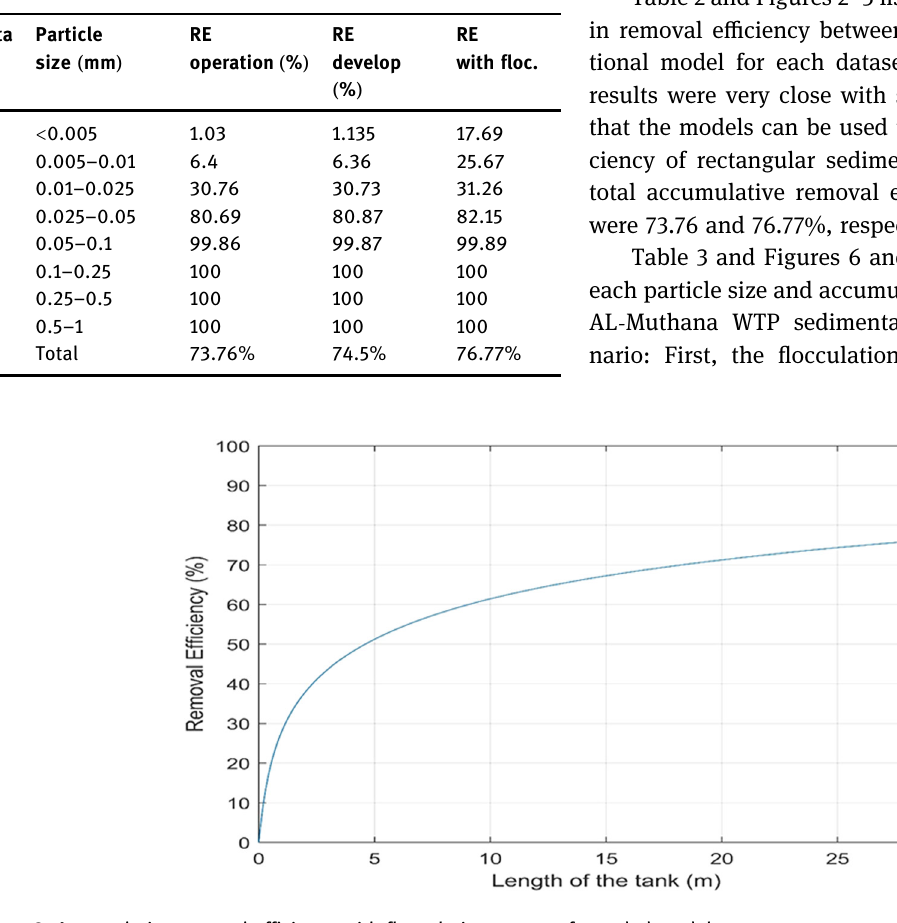
Figure 2: Accumulative removal e ffi ciency with fl occulation process for coded